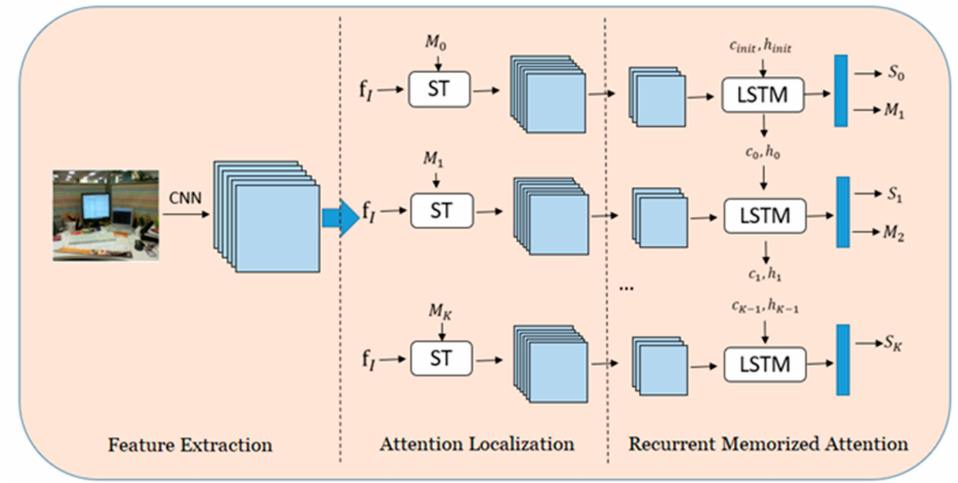
Figure 1. Proposed framework of recurrent memorized attention